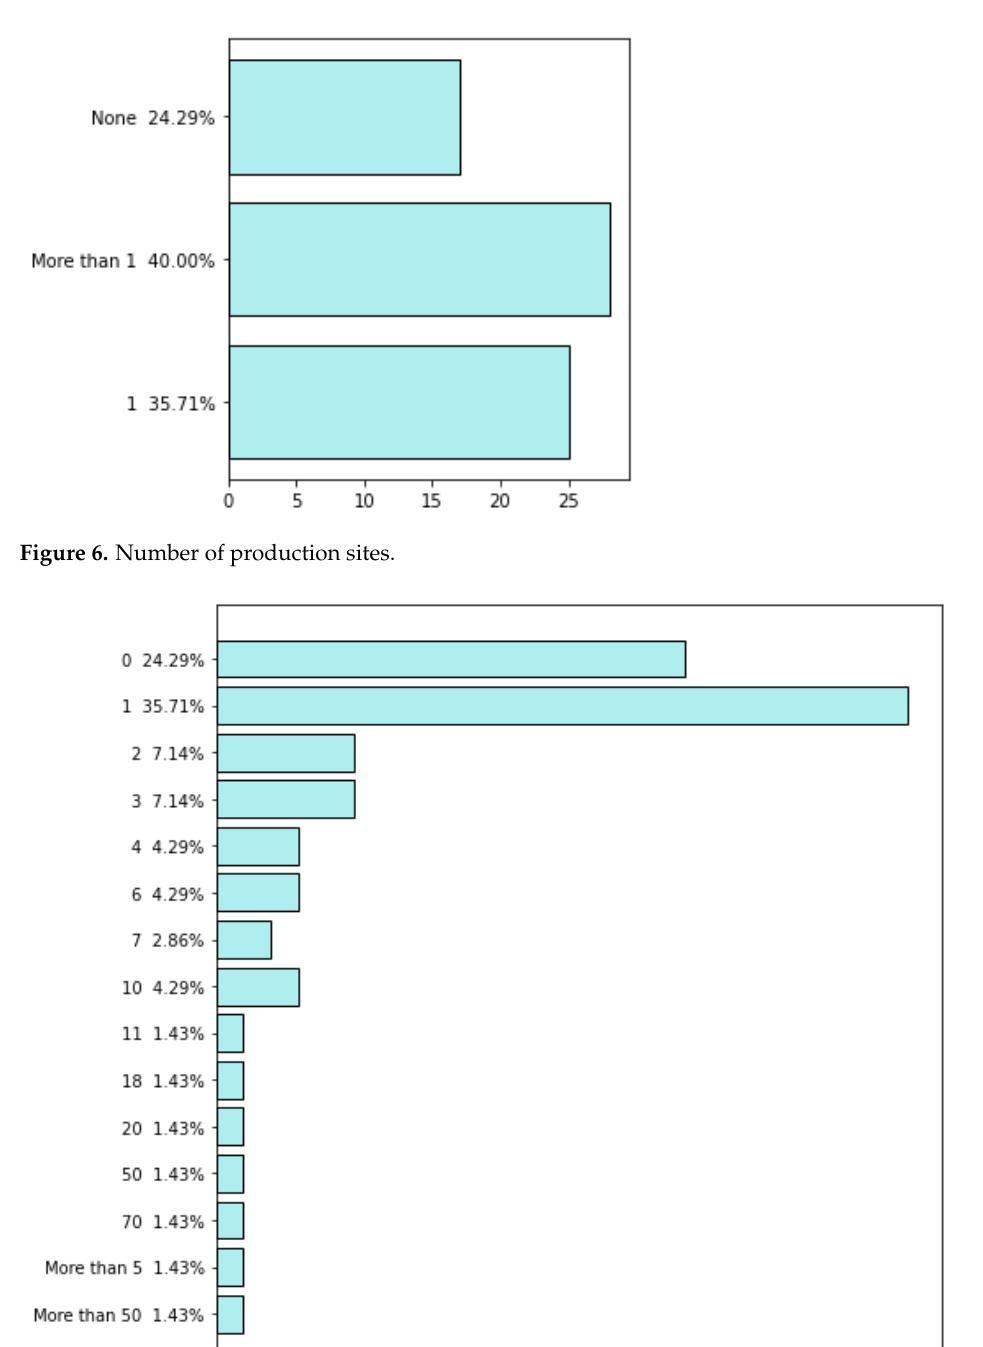
Figure 5. Percentage of questionnaires indicating the use of a specific type of production (one com- pany can carry out several types of production).